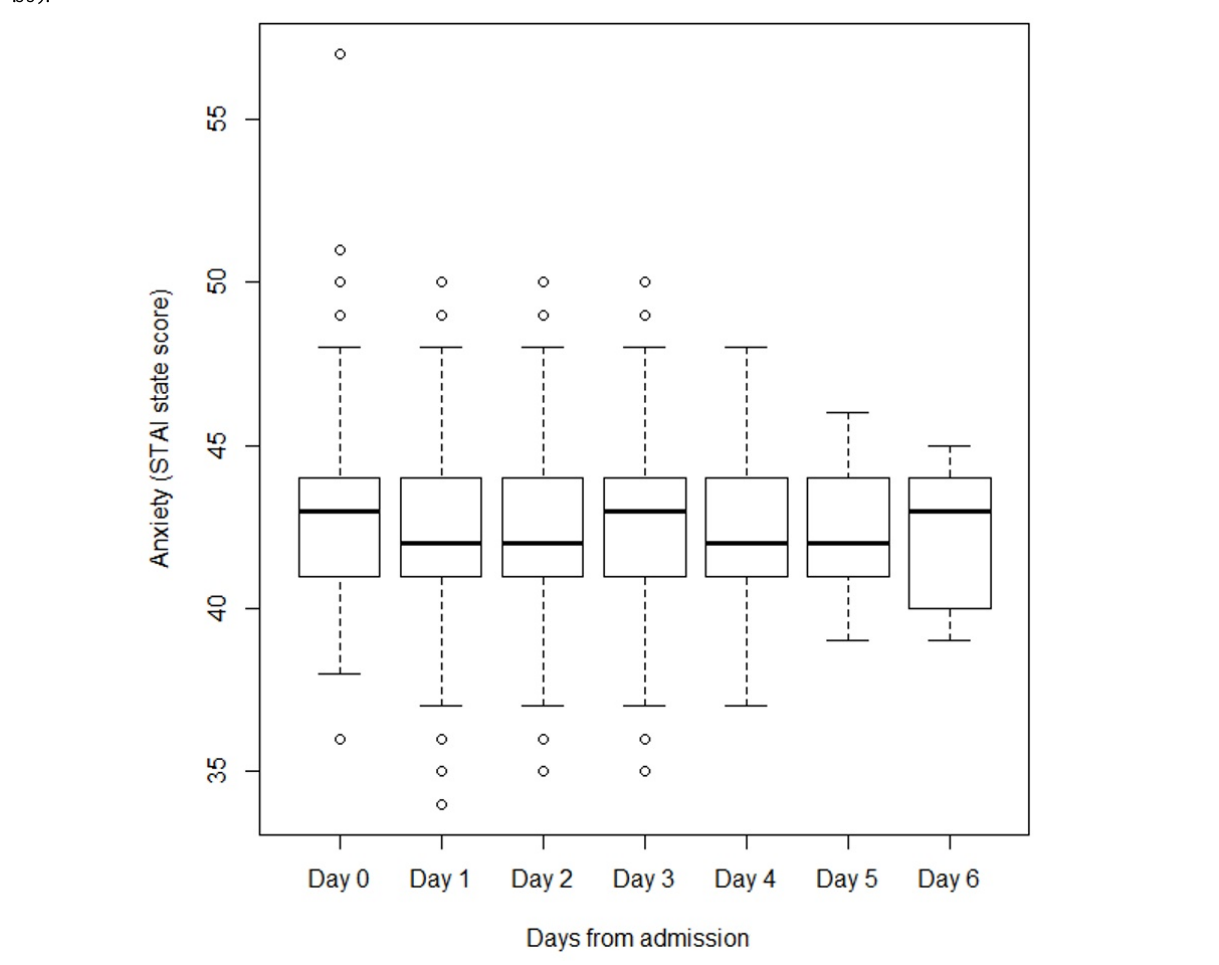
Figure 2. Anxiety levels, determined by the State-Trait Anxiety Inventory (STAI) state score during the first 6 days of hospitalization from admission ( P =.33).